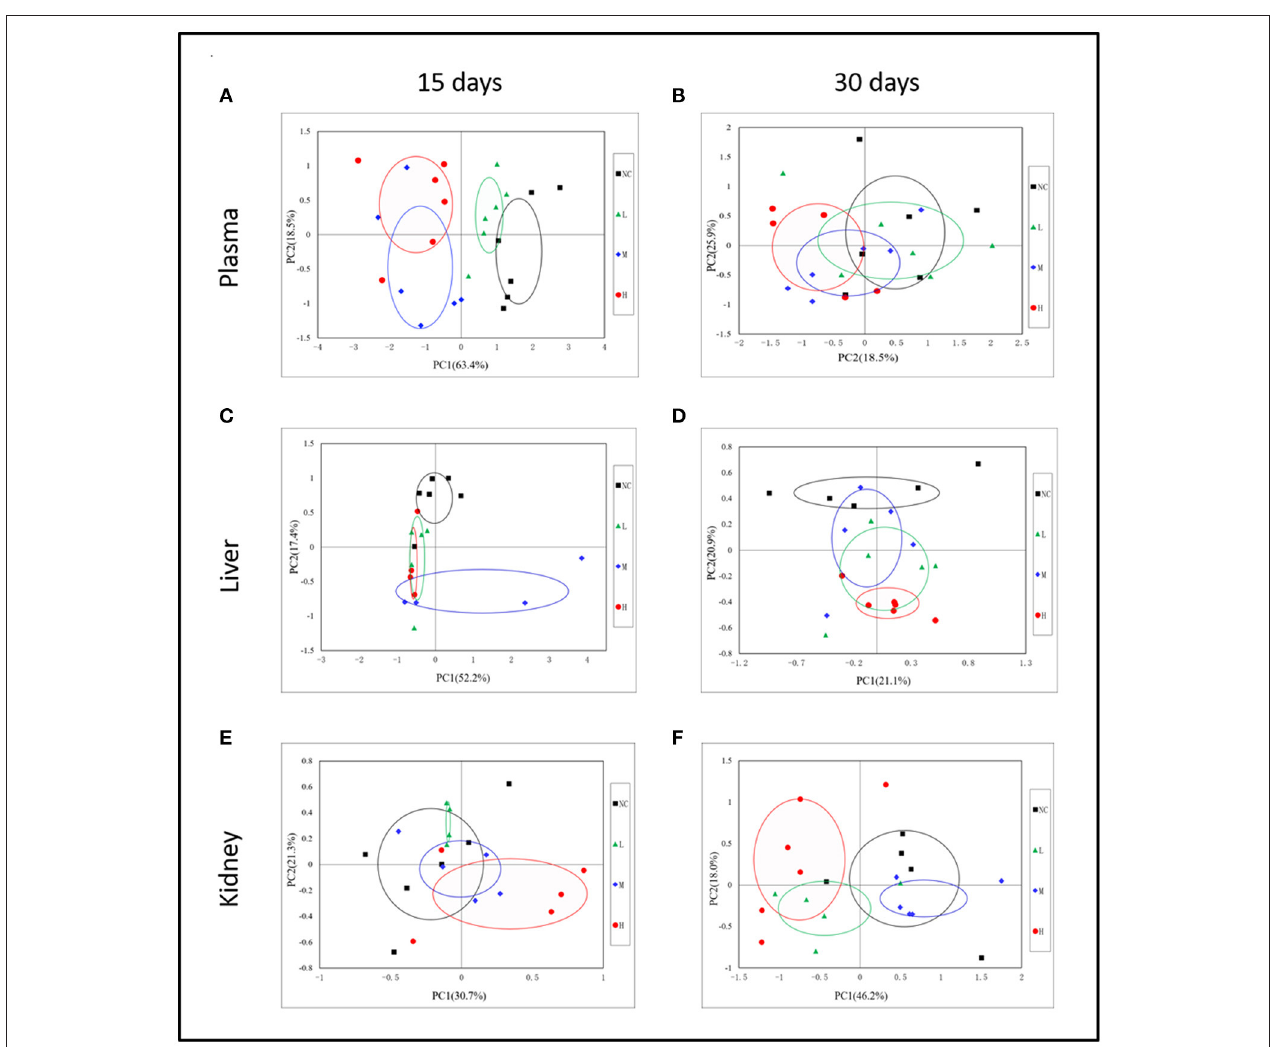
FIGURE 3 | Representative PCA score plots (PC1 vs. PC2) derived from the 1 H NMR data of plasma (A,B) , liver extract (C,D) , and kidney extract (E,F) from control and dosed groups at day 15 and day 30.